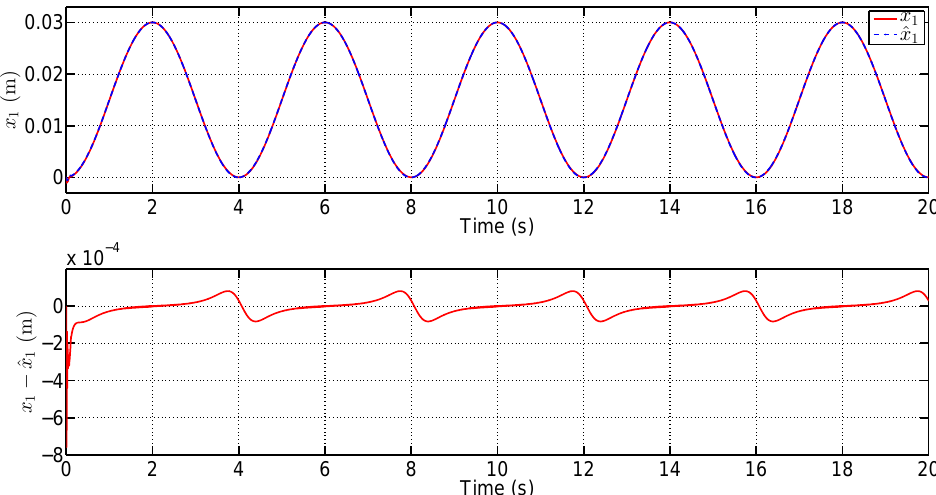
Figure 1. The performance of the